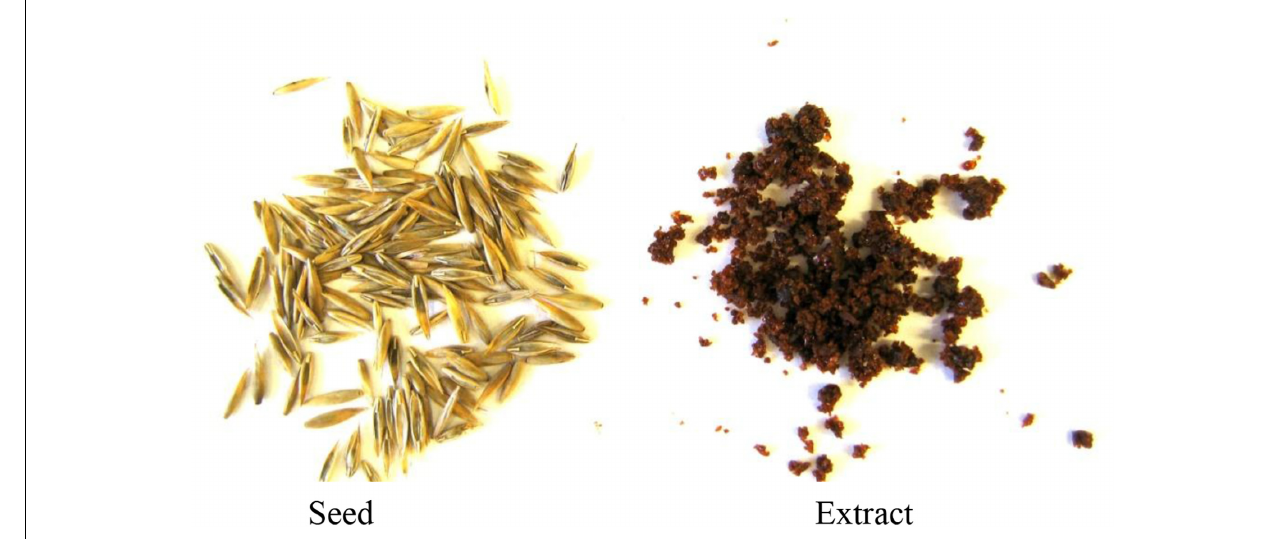
FIGURE 2 | Seed and initial dried